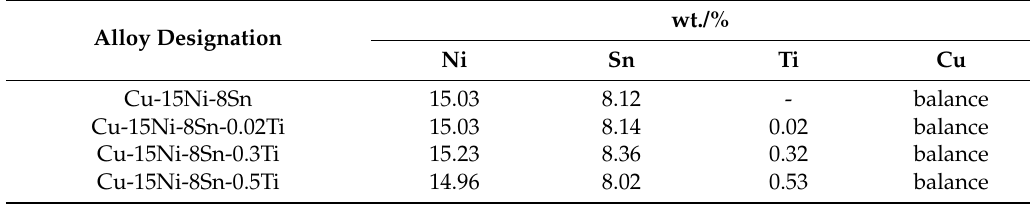
Table 1. Chemical composition of the Cu-15Ni-8Sn alloys with different Ti